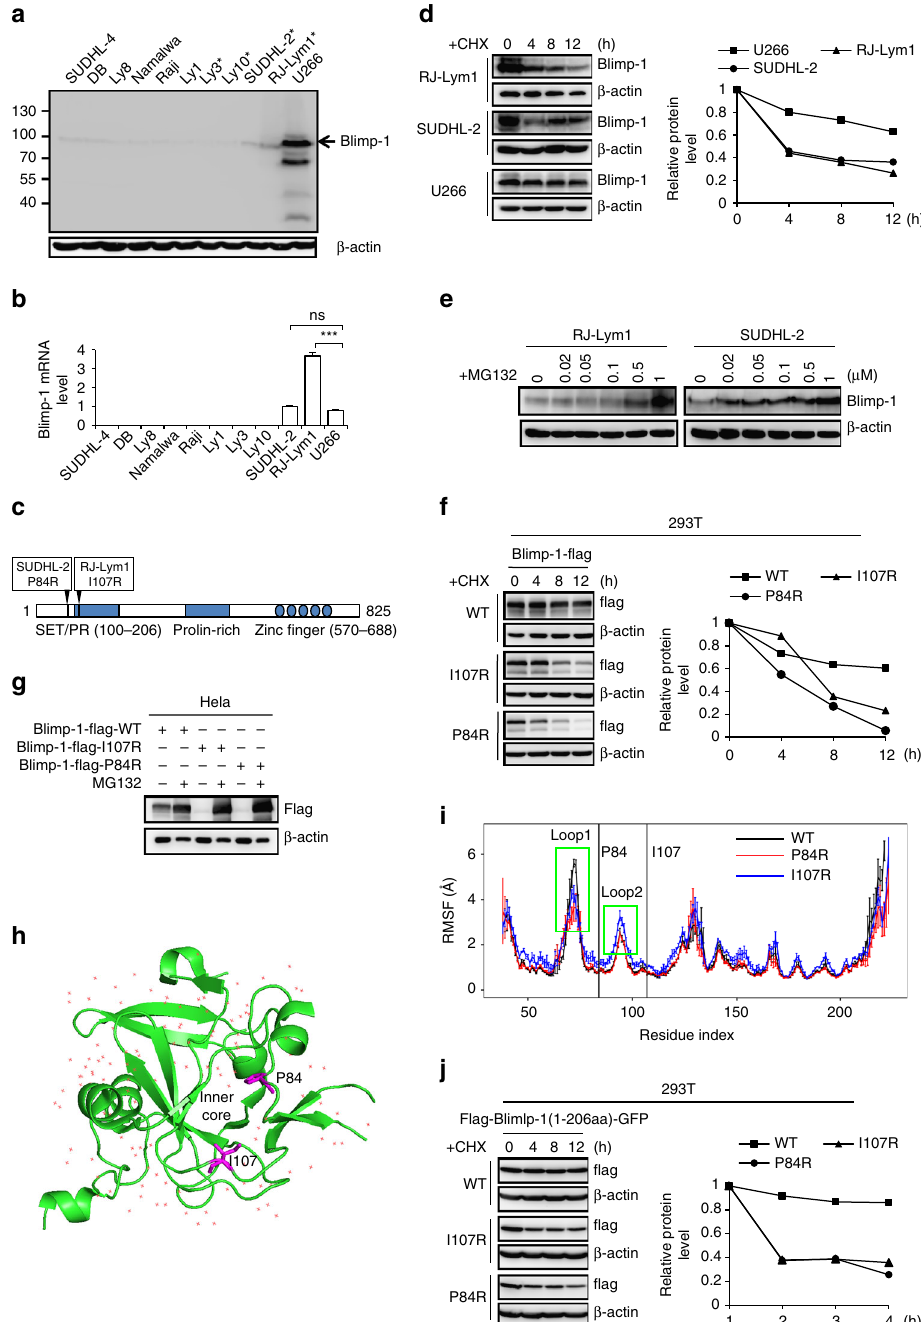
Fig. 1 N-terminal misfolding mutations sensitize Blimp-1 to proteasome-mediated degradation in lymphoma cells. Blimp-1 protein ( a ) and mRNA ( b ) levels in B-cell lymphoma and MM cells were measured by western blotting and semi-quantitative RT-PCR, respectively. The ABC-DLBCL cells are indicated with asterisks ( a ). c Diagram of the Blimp-1 domain structure, with the location of P84R and I107R indicated. d The Blimp-1 protein half-life in RJ-Lym1, SUDHL-2, or U266 cells was measured by western blotting after treatment with 50 mg ml − 1 CHX. The semi-quantitative protein levels are shown in the right panel . e The Blimp-1 protein level in RJ-Lym1 or SUDHL-2 cells was measured by western blotting 24 h after MG132 treatment at the indicated concentrations. f The half-life of fl ag-tagged WT Blimp-1, I107R mutant, or P84R mutant was measured as in c after 293T cells were transfected with the corresponding cDNAs. The semi-quantitative protein levels are shown in the right panel . g Western blot assay of the protein levels of WT or mutant Blimp-1 proteins expressed in HeLa cells exposed to MG132 treatment. h The slabbed view of the crystal structure of the WT N-terminal fragment (aa 38 – 223) with water locations shown. The P84 and I107 residues are shown in magentas and stick representation within the inner hydrophobic core. i The RMSF analyses of WT Blimp-1, the I107R mutant and the P84R mutant are shown in the right panel (values in Å). The positions of P84 and I107 are indicated with vertical lines. j The N-terminal fragments of WT or mutant Blimp-1 proteins (aa 1 – 206) were fused to GFP at its N terminus, and the half-lives of the fusion proteins were measured after expression in 293T cells as in f . Data are represented as mean ± SD. *** P <